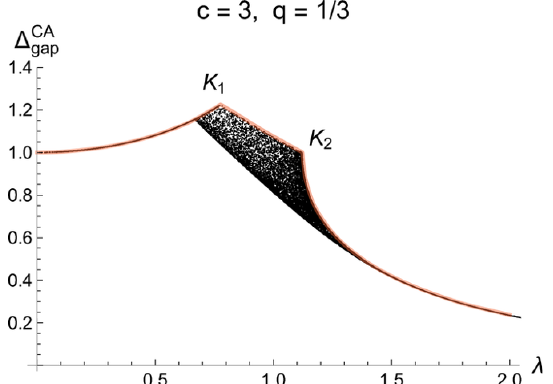
Figure 6. The T 2 = Z 3 free orbifold theory saturates the c = 3, q = 1 = (2 ; 2) conformal 3 N (cid:22) (cid:30) (cid:22) (cid:30) (cid:30) 1 (cid:30) 1 bootstrap of the four-point function . Here (cid:30) 1 is a q = (cid:22) q = 1 ( c; c ) primary (cid:0) 1 (cid:0) 1 3 h 3 3 3 3 i 3 operator and (cid:22) (cid:30) is its ( a; a ) conjugate. The vertical axis is the dimension (cid:1) CA of the lowest (cid:0) 1 gap 3 dimensional non-BPS primary in the chiral-antichiral channel. The horizontal axis is the chiral ring coe(cid:14)cient (cid:21) in the chiral-chiral channel. The red curve is the numerical bootstrap upper bound on (cid:1) CA , which depends on the value of the chiral ring coe(cid:14)cient (cid:21) we put into the crossing gap equation. The black dots are the analytic results ( (cid:21) ( R; b ) ; (cid:1) CA ( R; b )) (using (A.10) and (A.19)) gap of the = (2 ; 2) T 2 = Z 3 orbifold theory, by randomly sampling many points on the moduli space N ( R; b ). We see that there are some loci on the moduli space ( R; b ) of the T 2 = Z 3 orbifold theory saturating the numerical bootstrap bound.